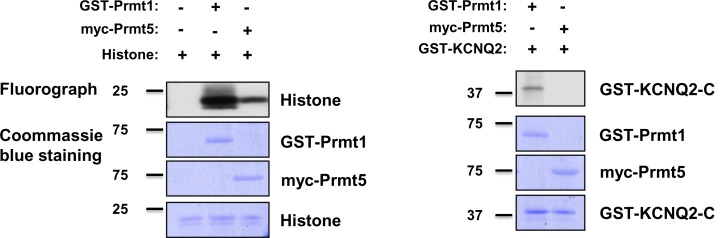
In vitro methylation assays with GST-Prmt1 or myc-Prmt5 together with GST-KCNQ2 (320-449 aa). In vitro methylation assays with myc-Prmt5 purified from HEK293T cells and GST-Prmt1 by using GST-KCNQ2 (aa 320–449) as a substrate and histone as a positive control. Coomassie blue stainings show the loading controls for each protein.